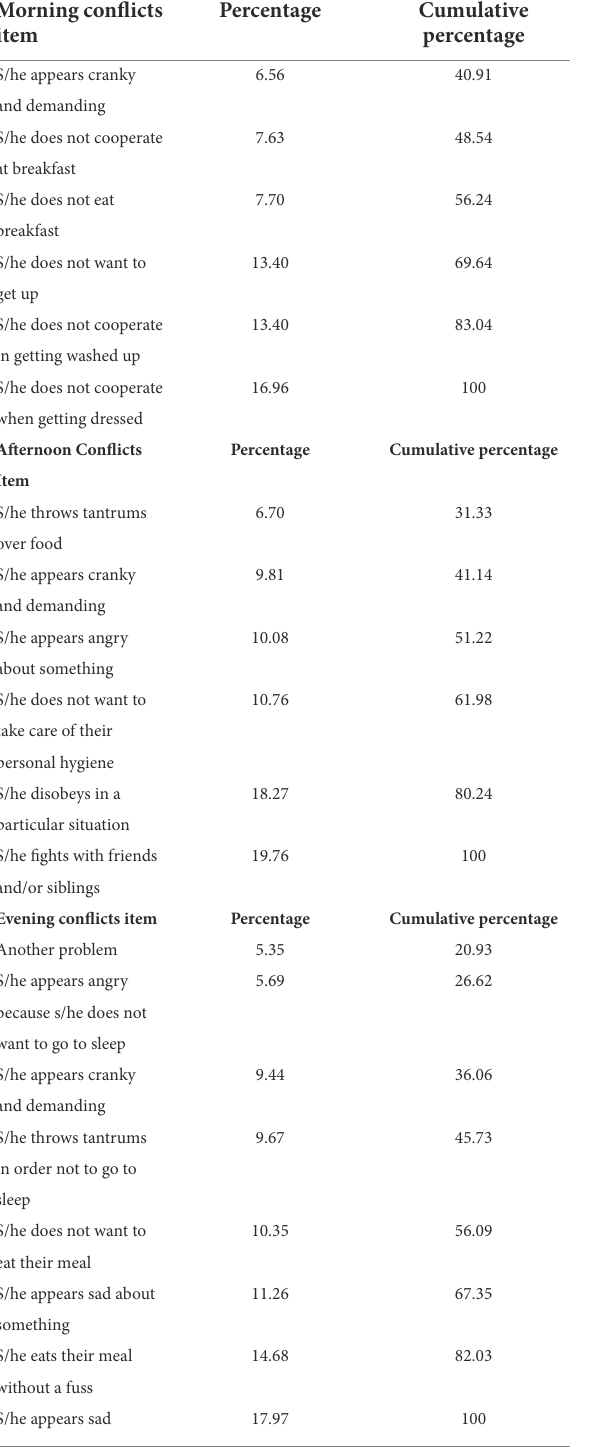
TABLE 3 Frequency distribution of items in the daily record of school